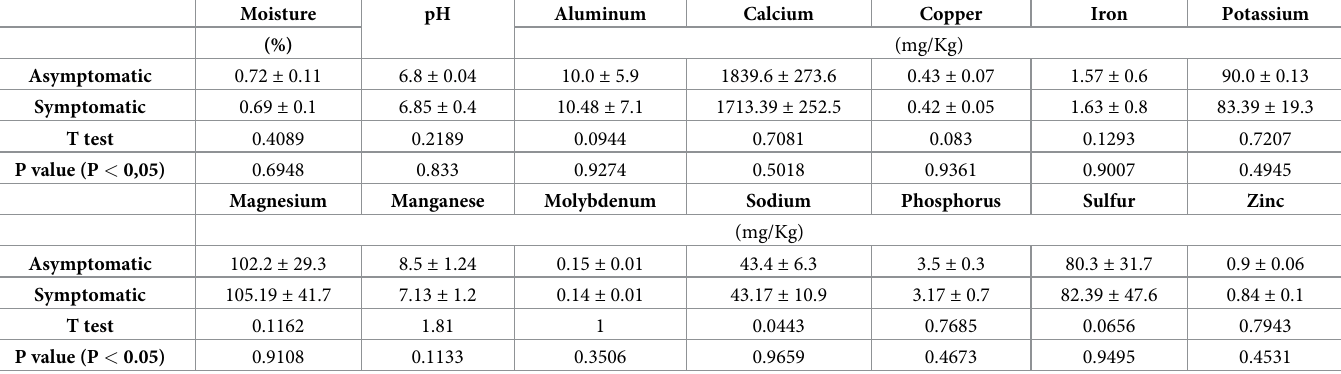
Table 1. Physicochemical properties and nutrient profiles from 0–20 cm topsoil in a commercial apple orchard in Wayne County, NY from RAD asymptomatic and symptomatic apple